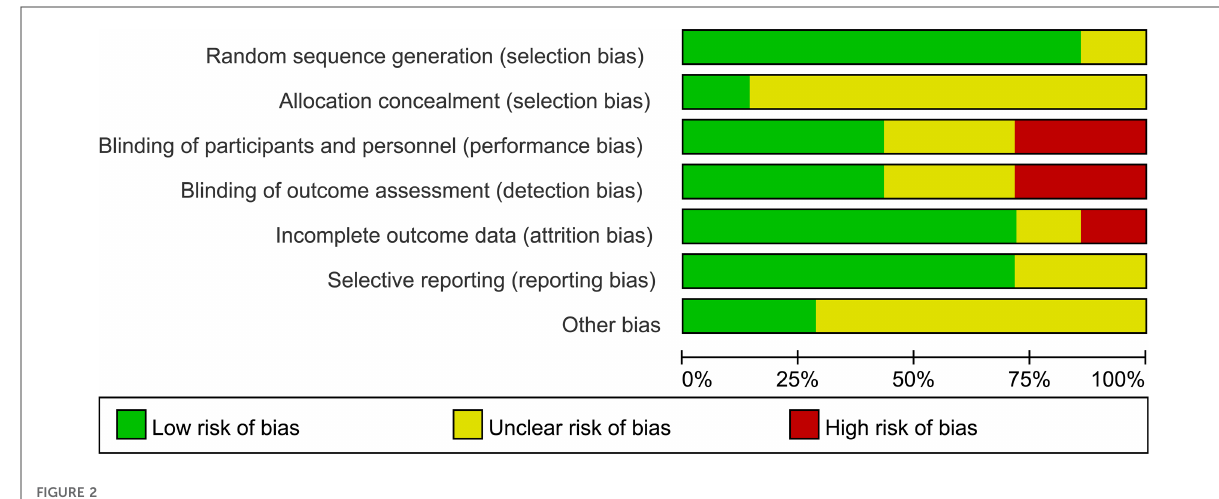
FIGURE 2 Summary of risks of bias of included